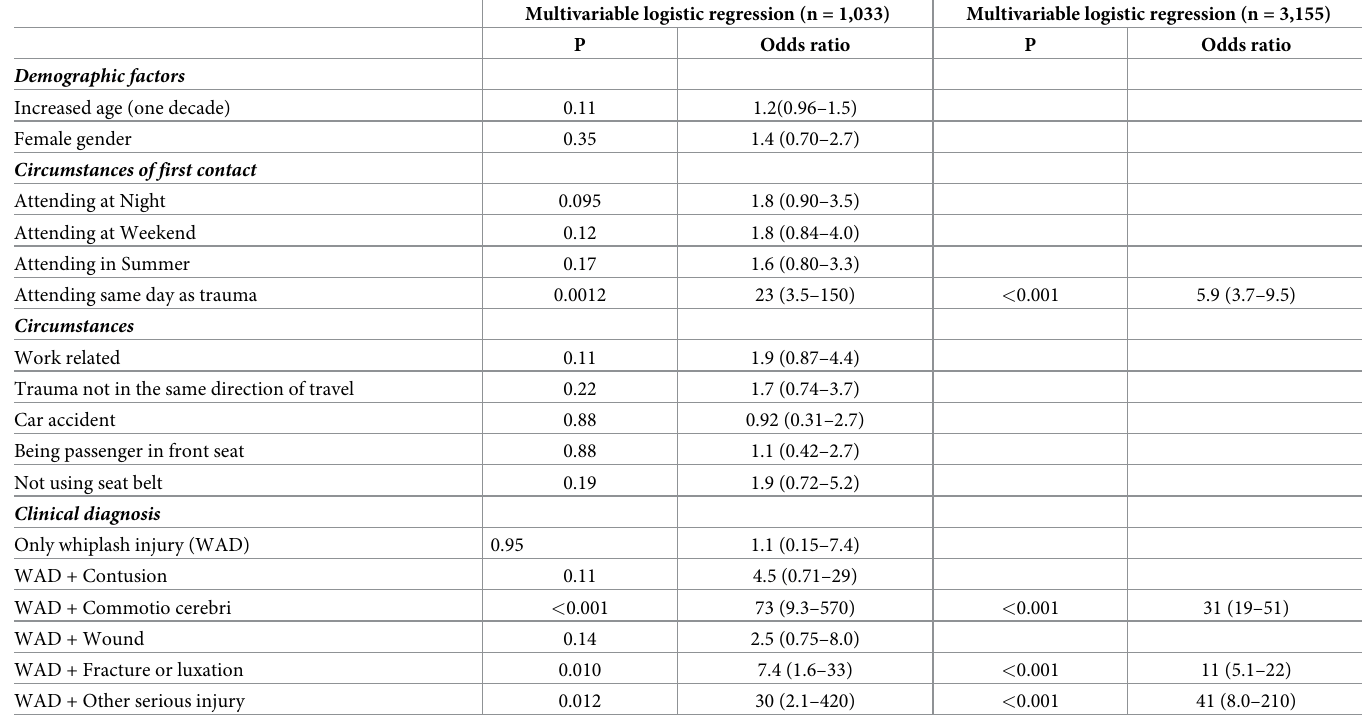
Table 2. Potential risk factors for hospital admission–no outliers